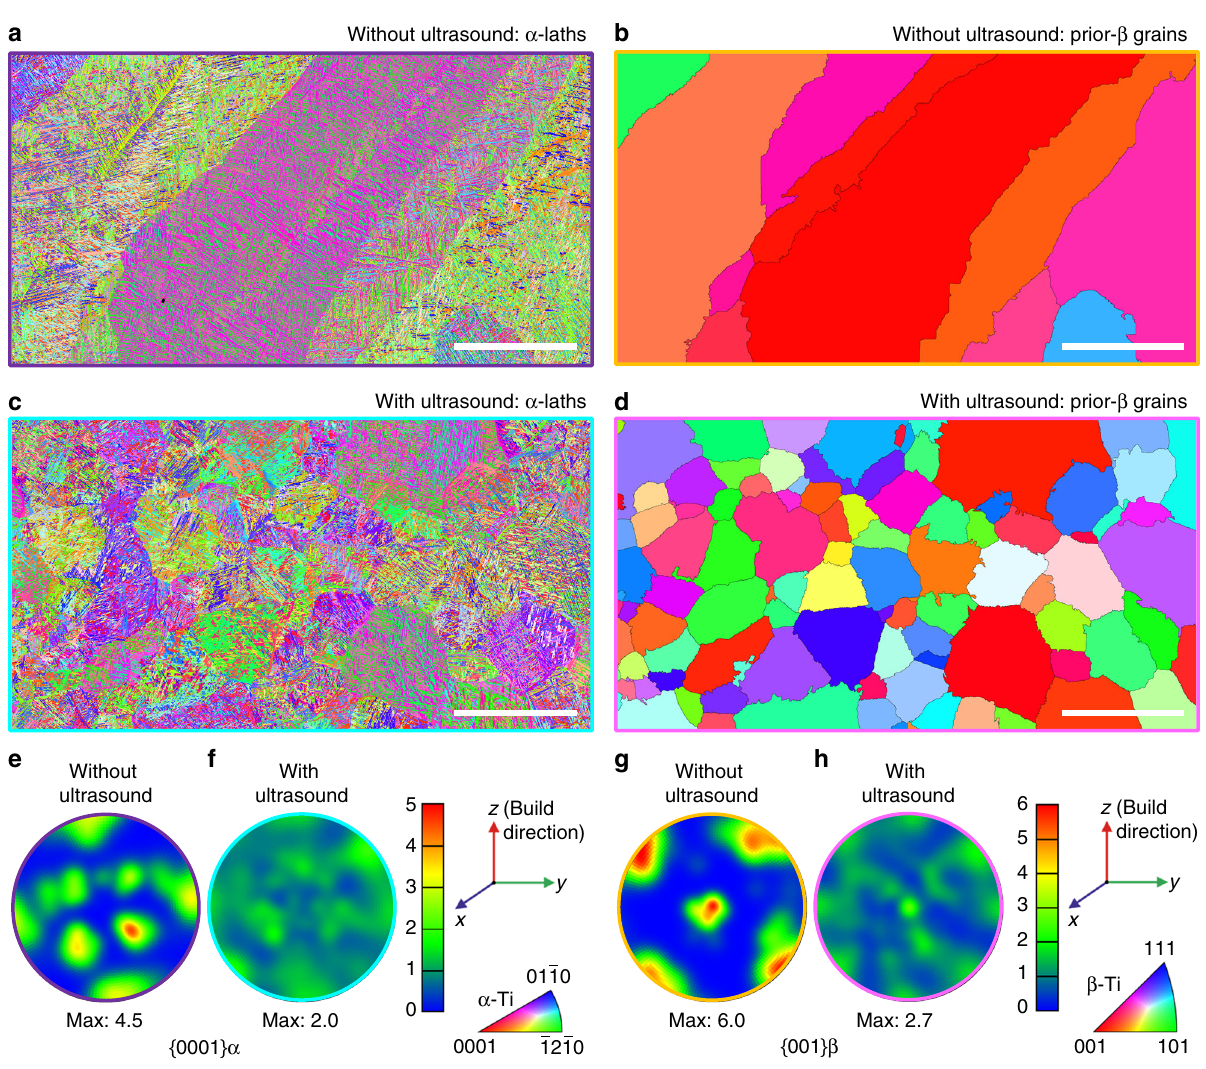
Fig. 4 Texture changes in AM-fabricated Ti-6Al-4V by high-intensity ultrasound. a , c Inverse pole fi gure maps along the build direction ( z ) for the α phase (measured by EBSD) in samples without ( a ) and with ( c ) ultrasound. b , d Inverse pole fi gure maps along the build direction ( z ) for the β phase (reconstructed from the α phase maps in a and c ) in samples without ( b ) and with ( d ) ultrasound. e , f {0001} contoured pole fi gures (in MUD: multiples of uniform distribution) of the measured α phase in samples without ( e ) and with ( f ) ultrasound. g , h {001} contoured pole fi gures (in MUD) of the reconstructed β phase in samples without ( g ) and with ( h ) ultrasound. Black lines in b and d indicate high angle grain boundaries (misorientation >10°). Scale bars, 250 μ